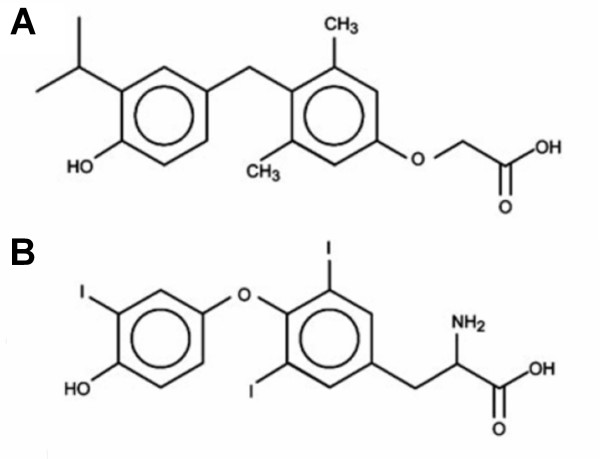
Bleicher1.png. Chemical formulas of GC-1 (a) and T3 (b).